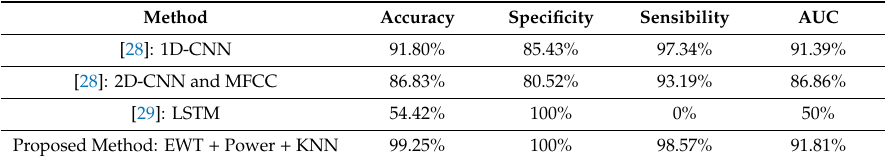
Table 16. Comparison of results between the methods in [28,29] and the proposed method.